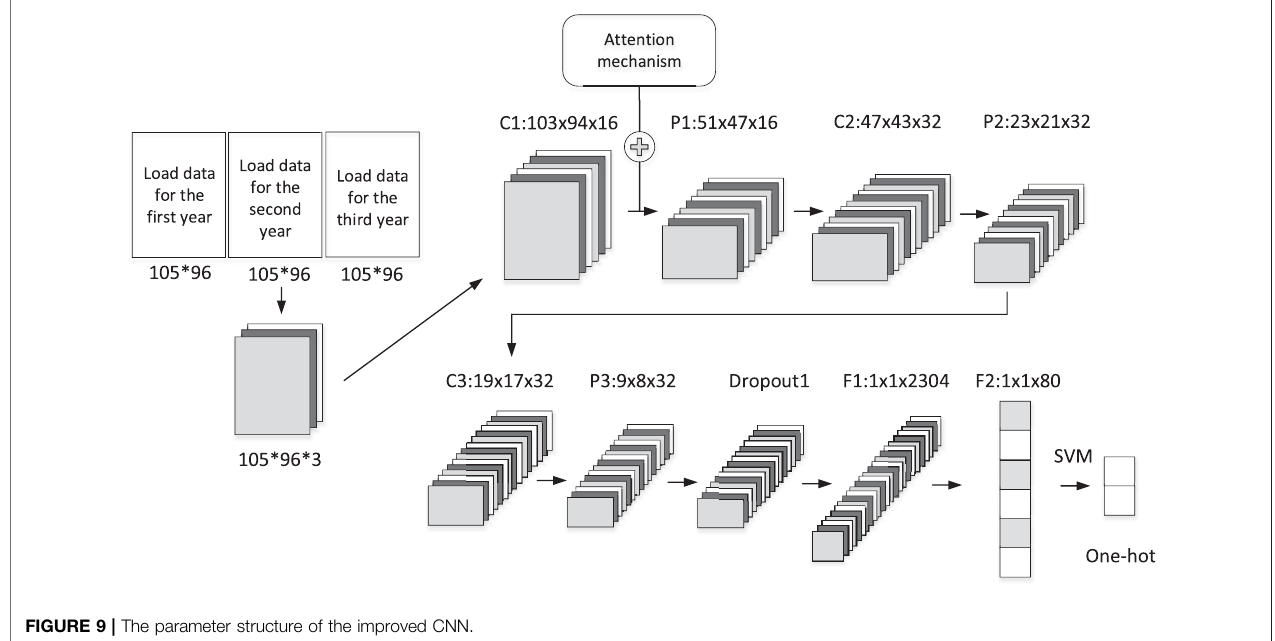
FIGURE 9 | The parameter structure of the improved CNN.